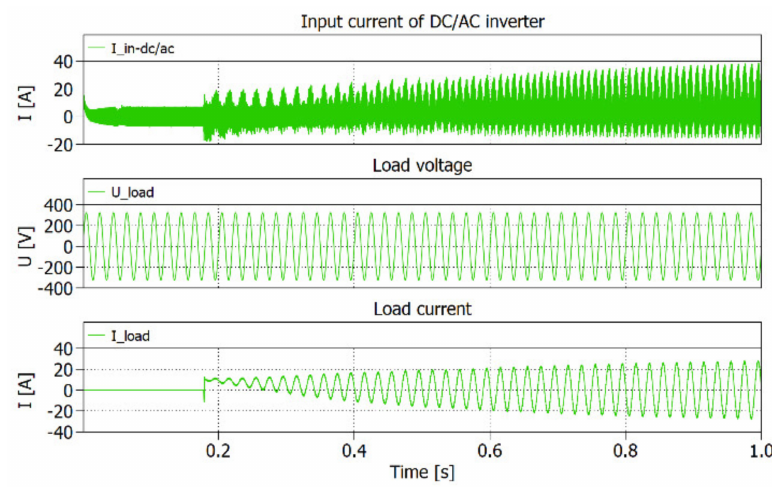
Figure 21. Current and voltage of grid load for Scenario